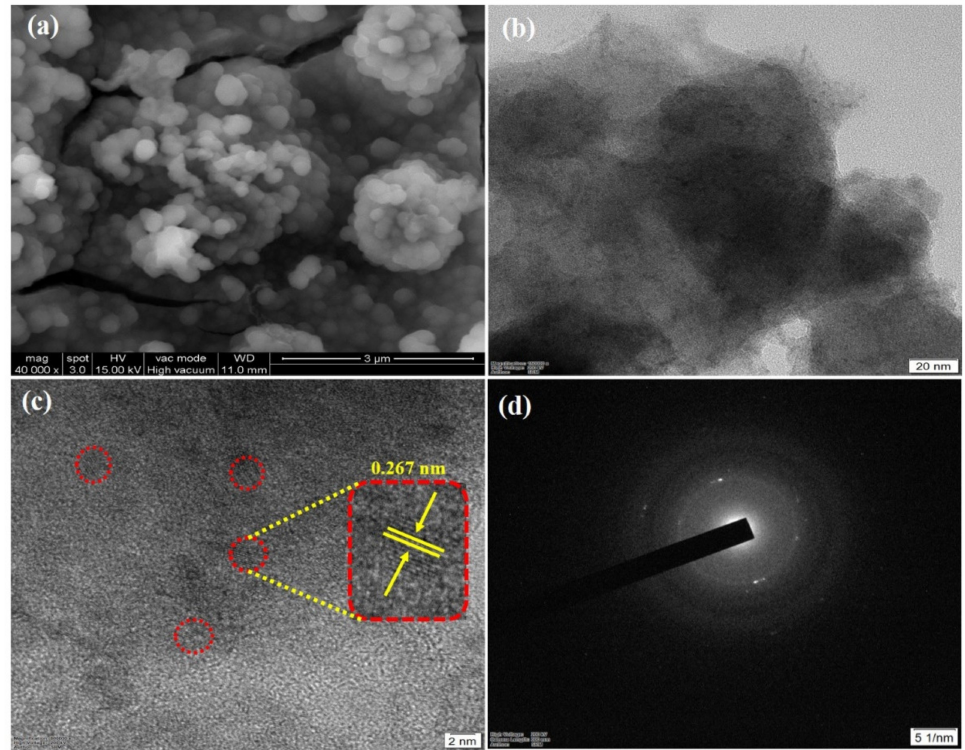
Figure 1. FE-SEM ( a ), TEM ( b ), HR-TEM ( c ) images, and SAED pattern ( d ) of the NC-NiS@NS-NiS